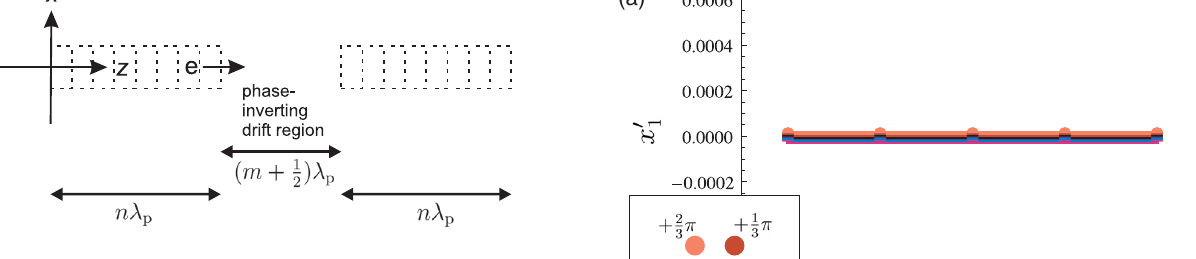
FIG. 6. A DLA accelerator segment analogous to a FODO structure.